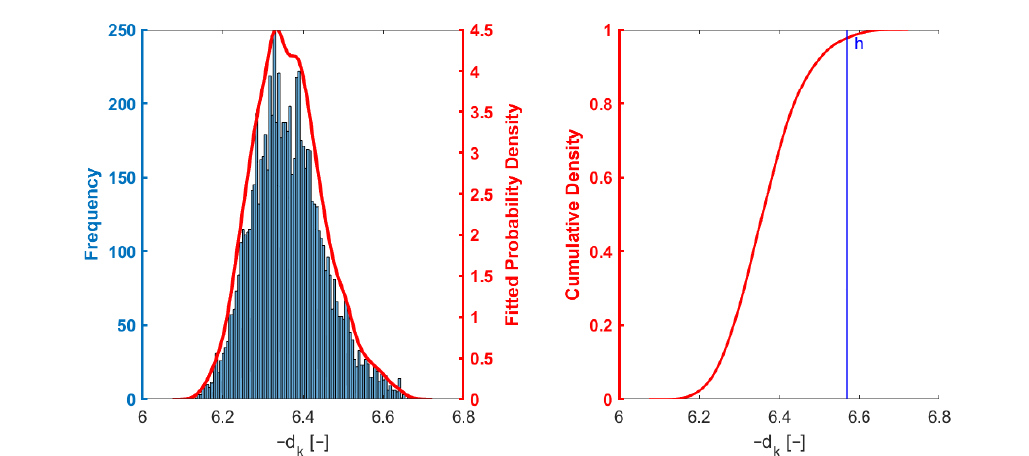
Figure 9. Fault-free operation with the IPF: the histogram, empirical probability density function (pdf), and cumulative distribution function (cdf) of − d k . Threshold h is denoted by a vertical line. The sliding window is M = 50. T = 8000.